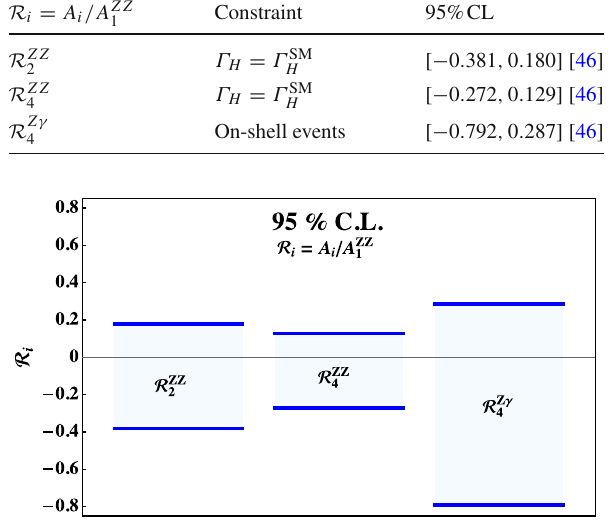
Fig. 2 Visual representation of bounds from Table 2